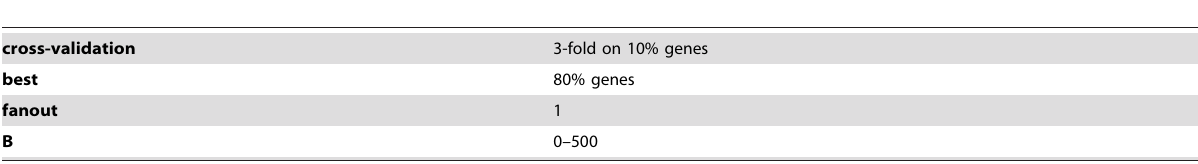
cross-validation